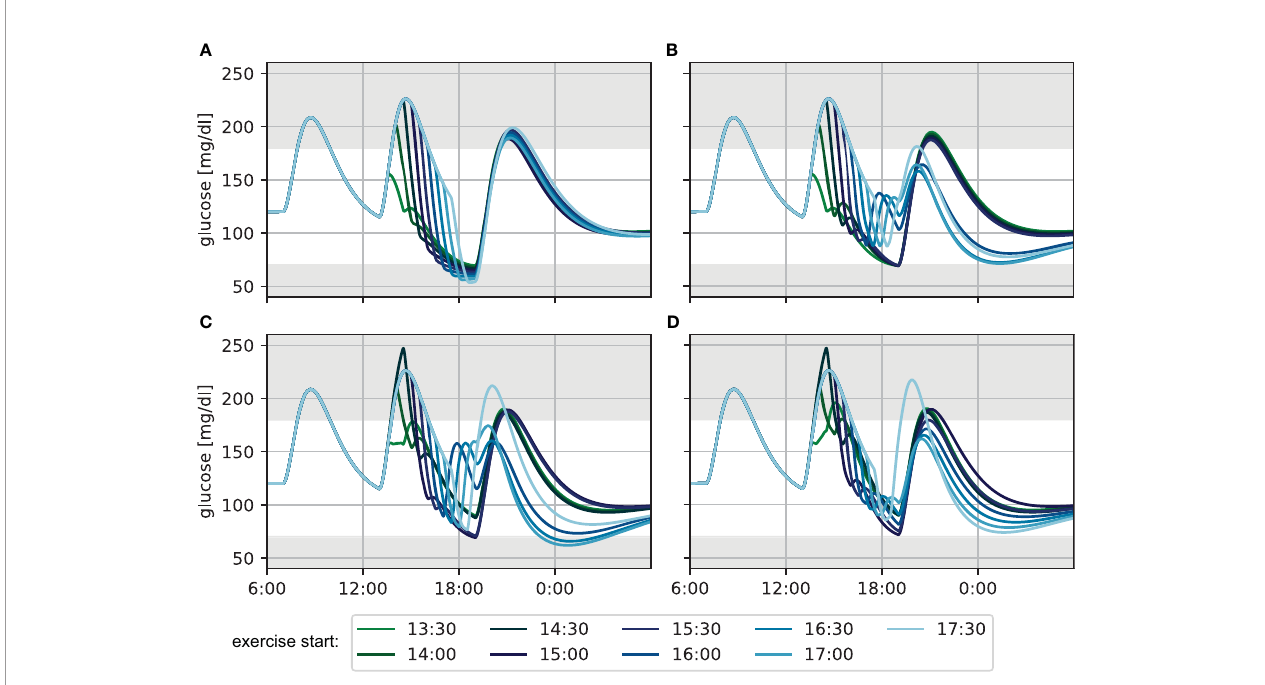
FIGURE 2 | Glucose levels for exercise performed at different times during the afternoon for 60 min at a heart rate of 120 bpm (A) without treatment adjustment to exercise, (B) with adjustment based on the CHO algorithm, (C) using the lower CHO recommendation of the consensus guidelines and (D) using the upper CHO recommendation of the consensus